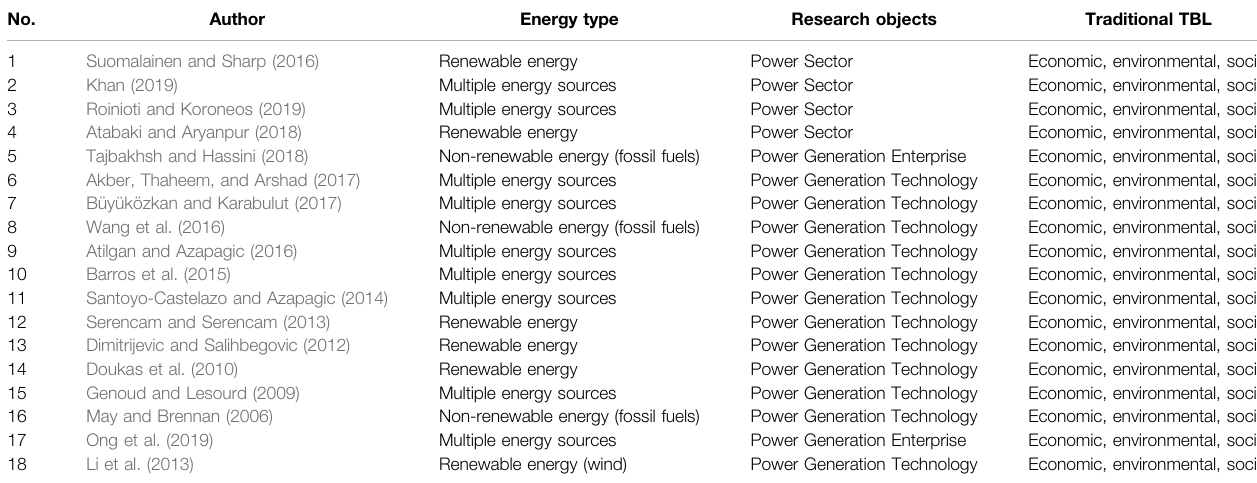
TABLE 3 | Summary of these articles using the traditional triple bottom